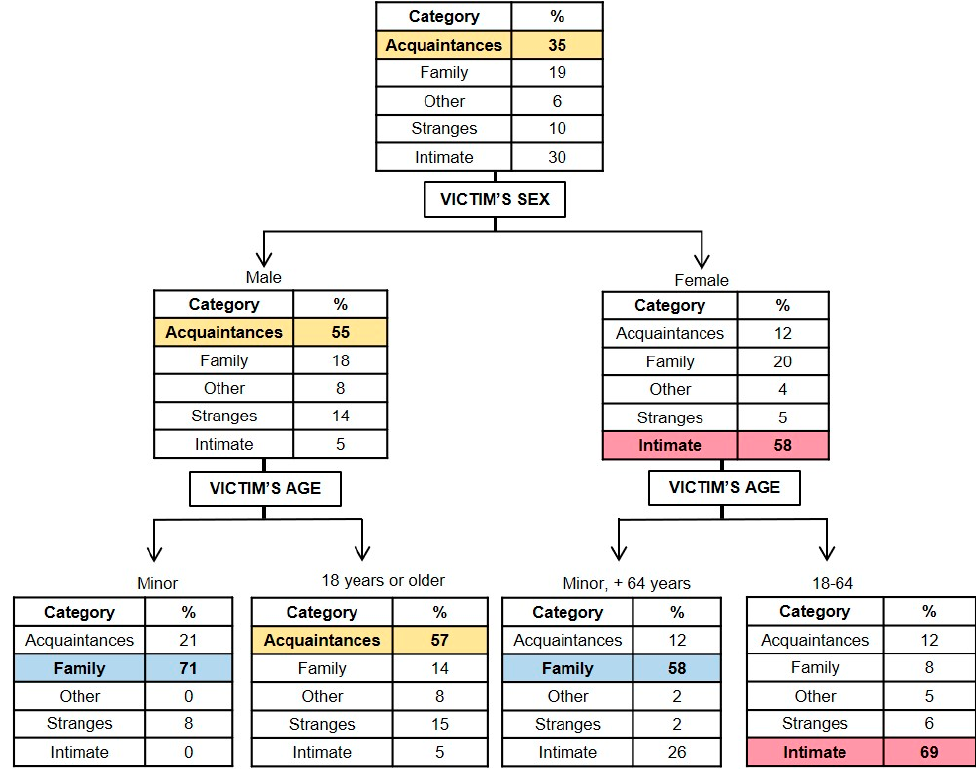
Figure 6. Graphical representation of the classification tree for the type of relationship between the victim and the aggressor. The category “Acquaintances” includes known individuals / neighbors, friends, work / commercial relationships and school relationships. The category “Intimate” includes couples, spouses, ex-partners, separated or divorced.